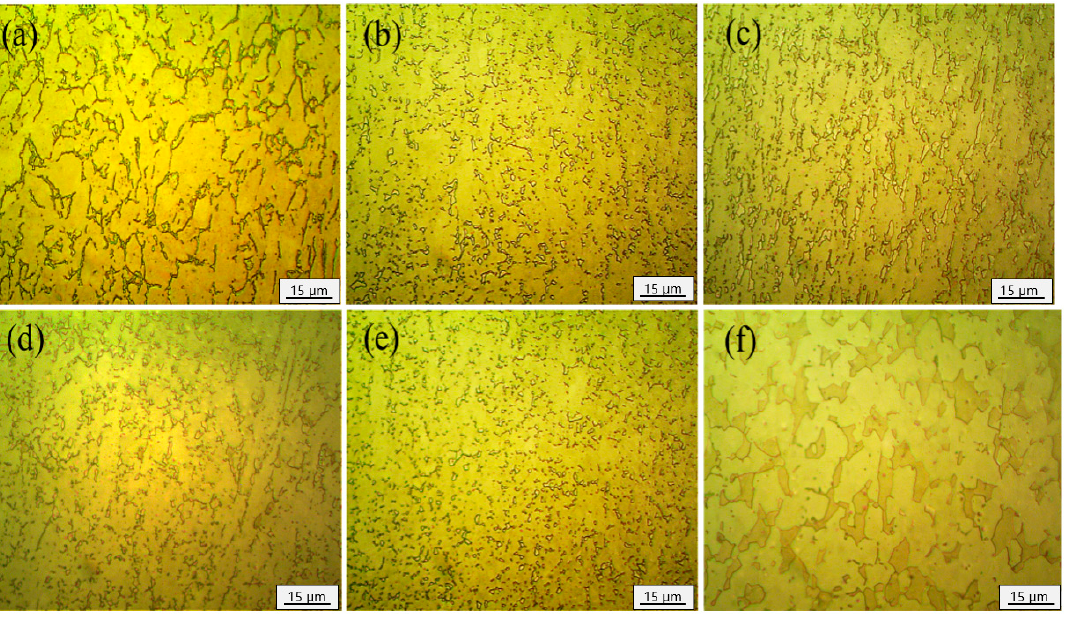
Figure 4. Optical microstructures of as-rolled Ti55 alloy sheet specimens at ( a ) as-rolled condition; ( b ) 800 °C–0.001 s − 1 , the true strain of about 0.97; ( c ) 850 °C–0.1 s − 1 , the true strain of about 0.87; ( d ) 850 °C– 0.01 s − 1 , the true strain of about 0.75; ( e ) 850 °C–0.001 s − 1 , the true strain of about 1.13; ( f ) 900 °C–0.001 s − 1 , the true strain of about 1.67.